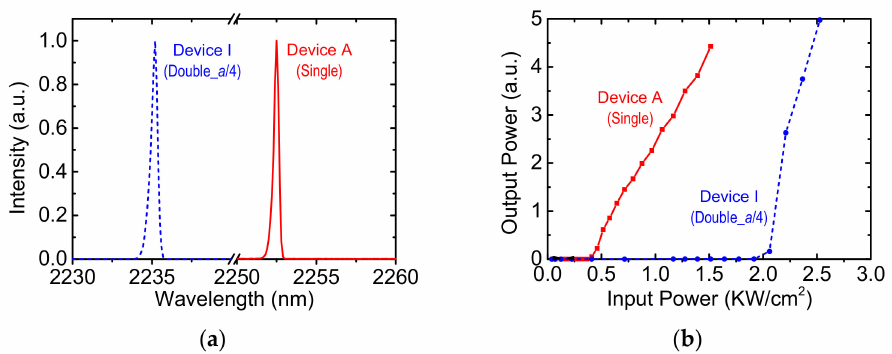
Figure 4. The optically pumped ( a ) lasing spectra and ( b ) L-L characteristics for Device A and I.